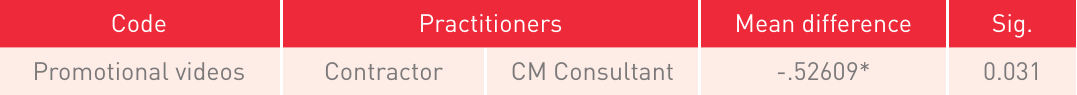
Games-Howell Post-hoc Test for the level of interest among construction practitioners Code Practitioners Mean difference Sig. Promotional videos Contractor